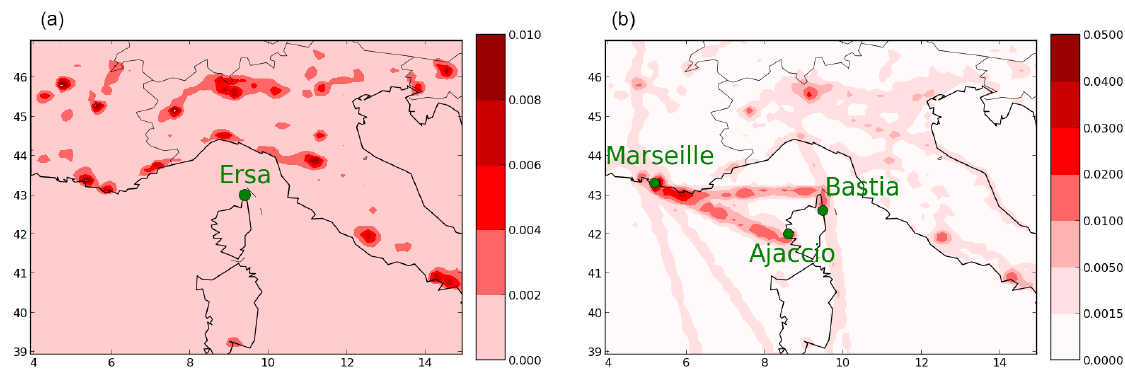
Figure 1. Surface emissions of POAs from the residential heating sector (a) and from the other six anthropogenic sectors (b) during winter 2014. The emissions are in µgm − 2 s − 1